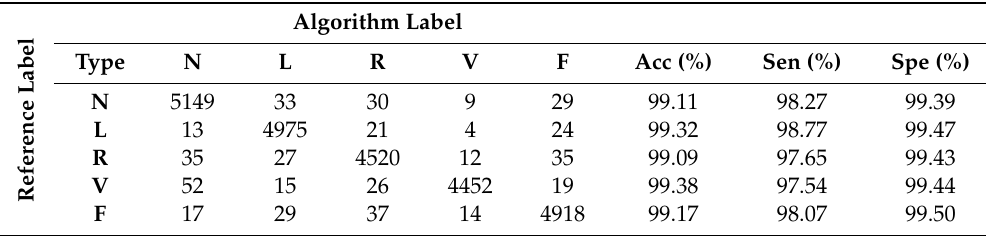
Figure 13. Score threshold test results.